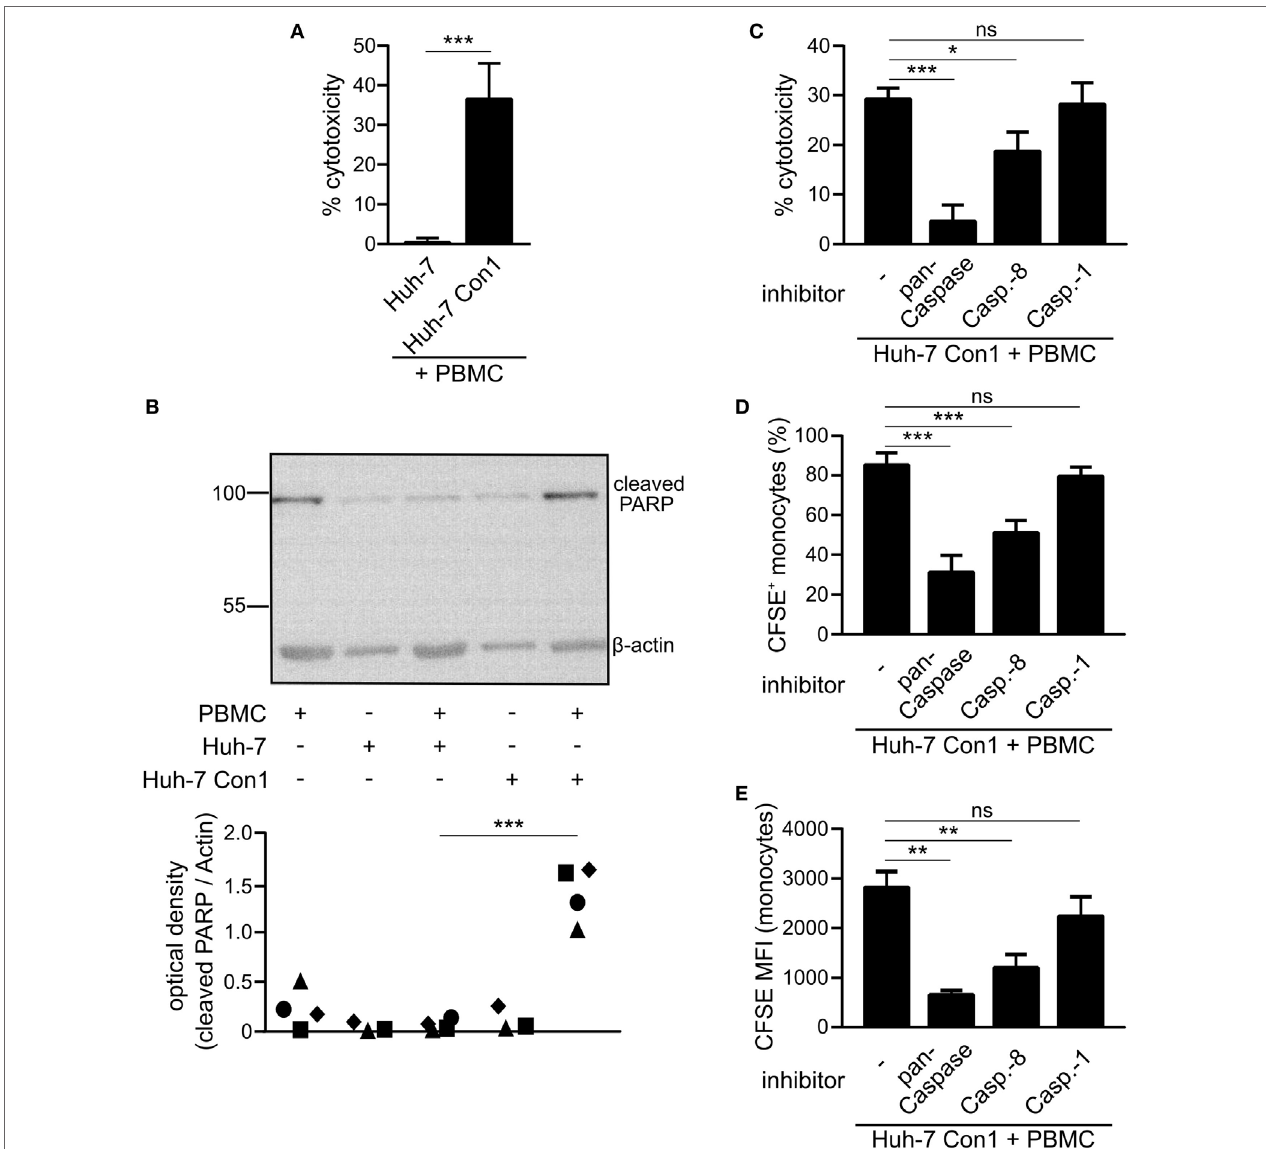
FigUre 5 | Killing of hepatitis C virus subgenomic replicon cells by peripheral blood mononuclear cells (PBMCs). Huh-7 cells were co-cultured with PBMCs overnight. (a) Supernatants were collected and measured for lactate dehydrogenase (LDH) activity ( n = 5). (B) Cells were harvested and poly (ADP-ribose) polymerase (PARP) cleavage was analyzed by Western Blot ( n = 3–4). (c–e) Huh-7 Con1 cells were co-cultured with PBMCs in presence of pan-Caspase inhibitor Z-VAD-FMK (20 µM), Caspase-8 inhibitor Z-IETD-FMK (20 µM), or Caspase-1 inhibitor Z-YVAD-FMK (20 µM). After overnight incubation LDH release was measured in the supernatant (c) , percentage of CFSE + monocytes (D) and carboxyfluorescein succinimidyl ester (CFSE) mean fluorescence intensity (MFI) of monocytes (e) was determined by flow cytometry ( n =